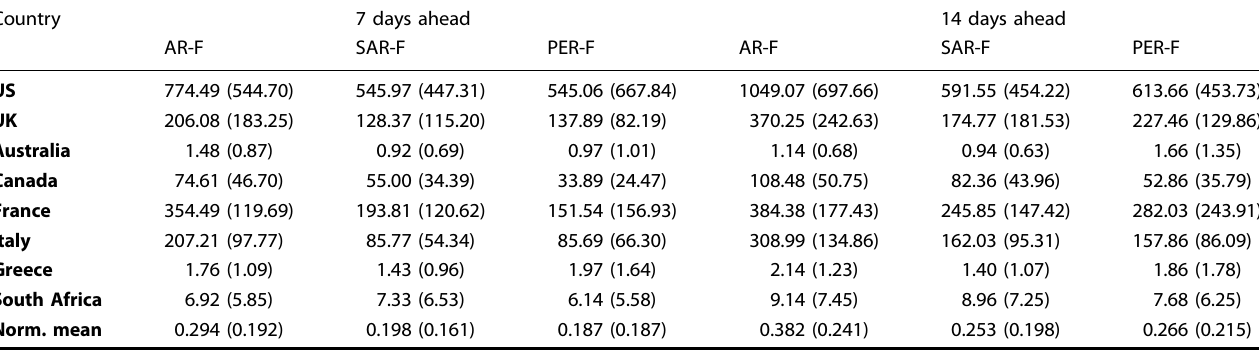
The last row contains min-max normalised averages across countries, methods, and forecasting tasks to account for the different ranges in different countries. AR-F autoregressive forecasting using past deaths, SAR-F combined online search and autoregressive forecasting, PER-F persistence model.